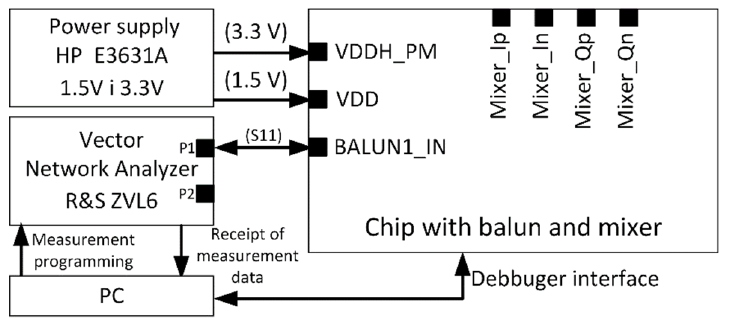
Figure 20. Environment for measuring the input impedance matching (S11) of the balun.